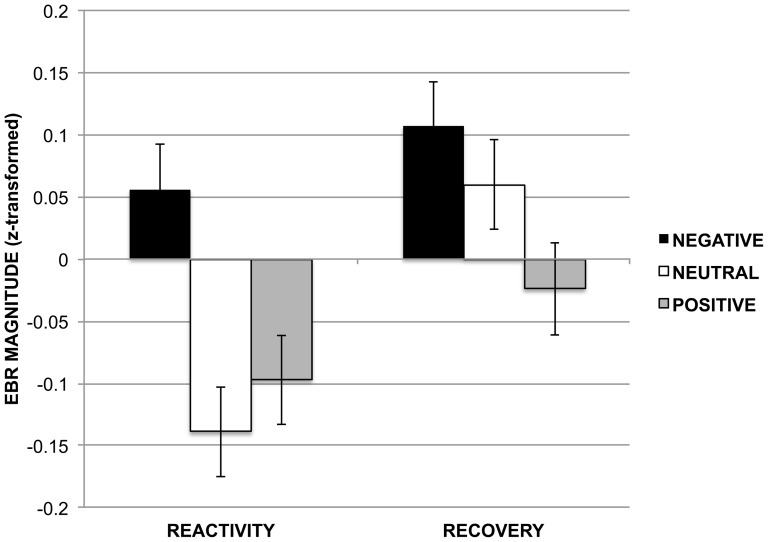
Manipulation check.Emotion modulation was observed in the EBR measures with a significant main effect of valence: EBR magnitude was greater on negative compared to both neutral and positive trials across probe times. A main effect of probe time showed larger EBR magnitude across valences in response to the recovery probe after picture offset when the computer screen was black than to the reactivity probe during the picture presentation (consistent with findings of larger responses to startling stimuli in darkness than in light). Mean EBR magnitude was significantly greater on negative than both neutral and positive trials at the reactivity probe, and greater on negative than positive trials at the recovery probe.